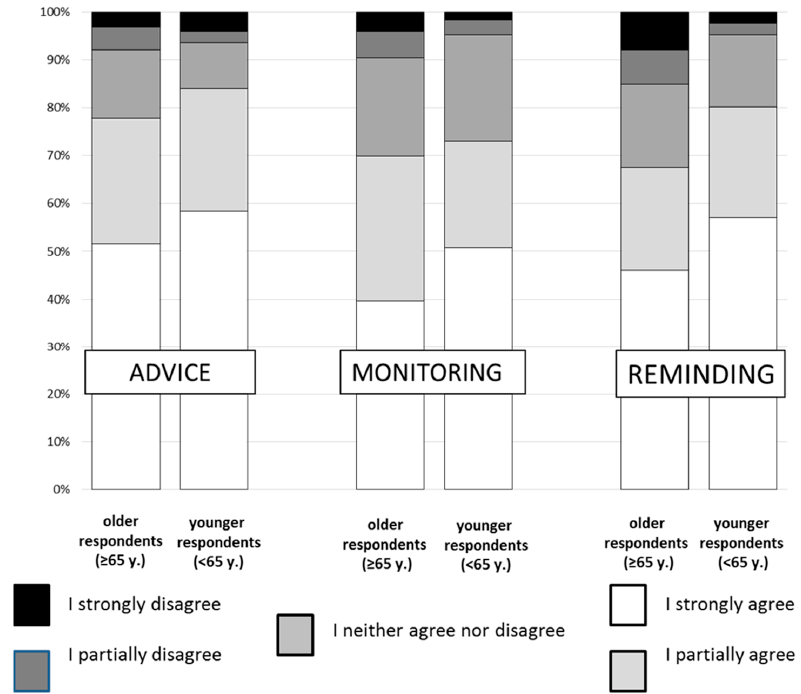
Figure 1. Opinions of older and younger respondents about the role of a robot in older persons’ diet. y.—years.